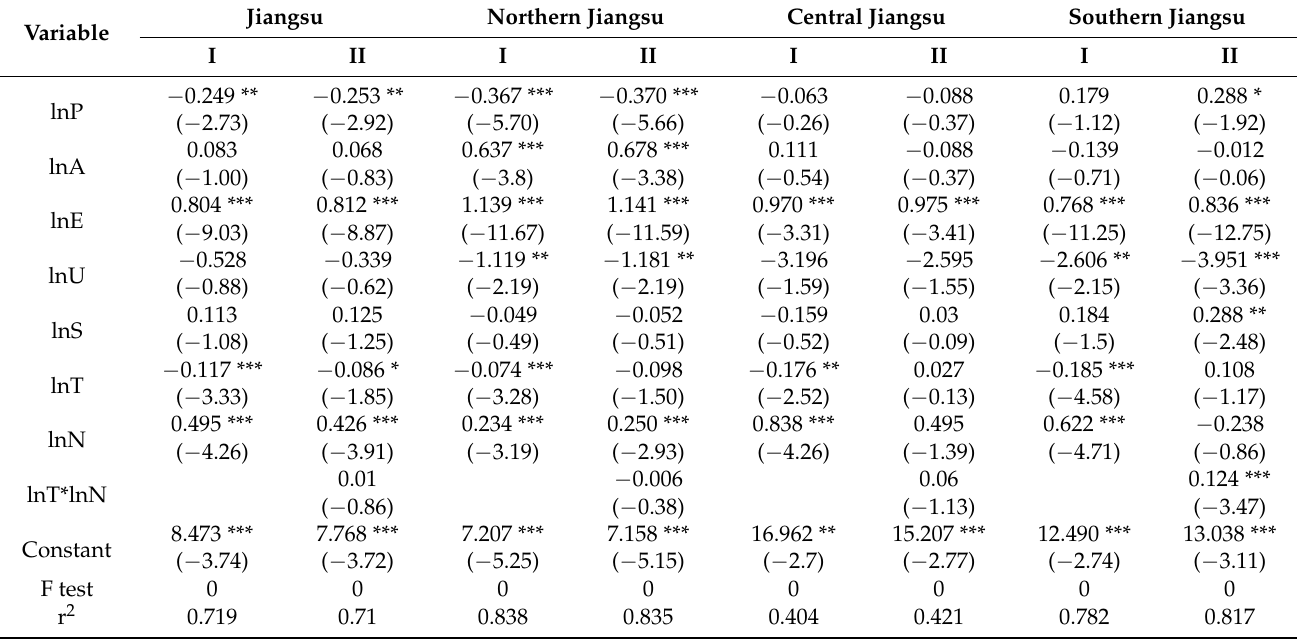
Table 6. Regression results of the fixed-effects model.